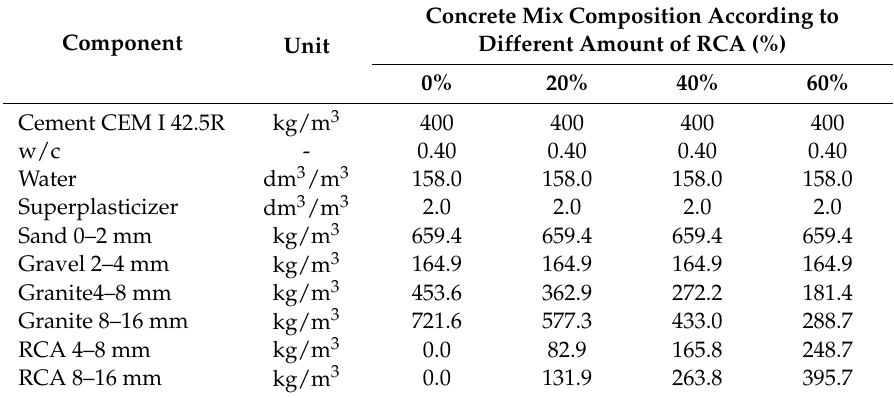
Table 6. The composition of the concrete mixes on 1 m 3 depending on the content of recycled